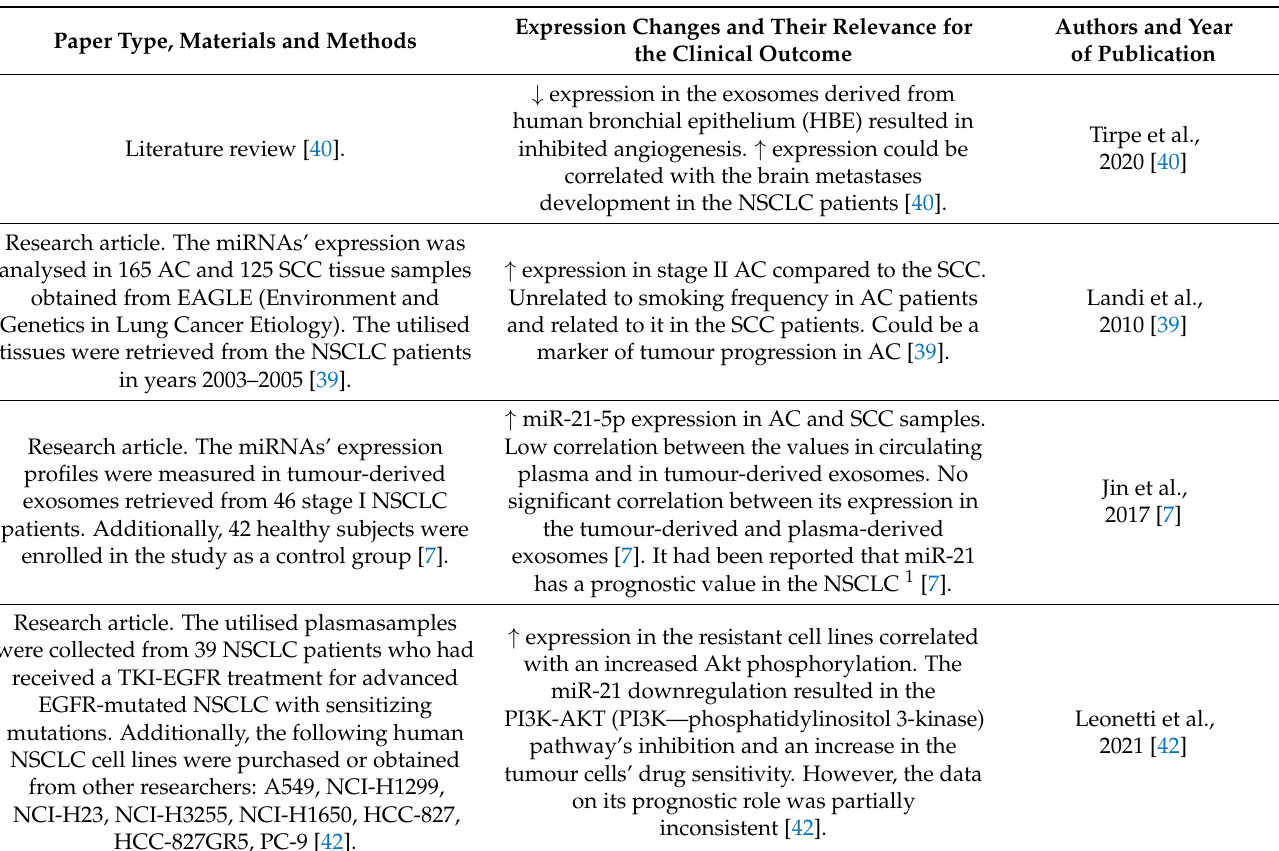
Table 1. The prognostic role of the miR-21 in